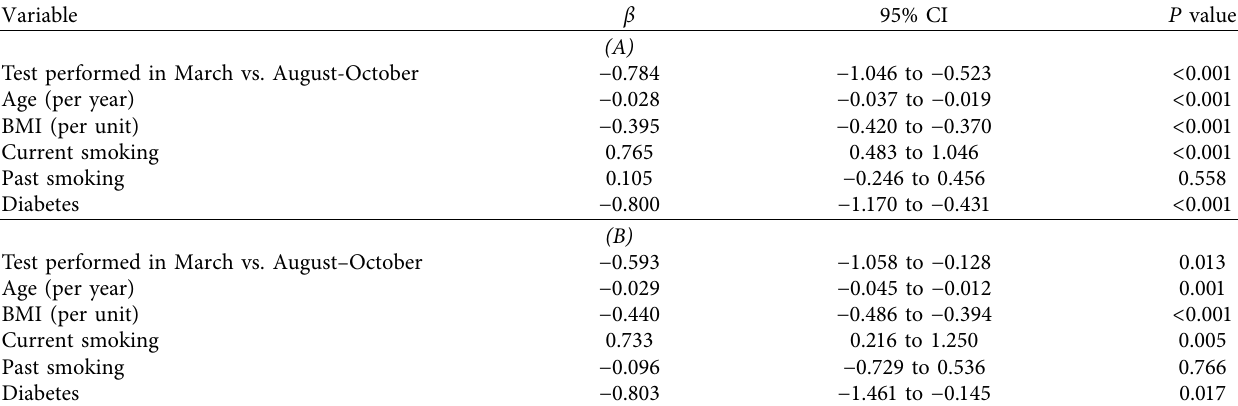
Table 4: Linear regression analysis of variables associated with total testosterone (A) and bioavailable testosterone (B).